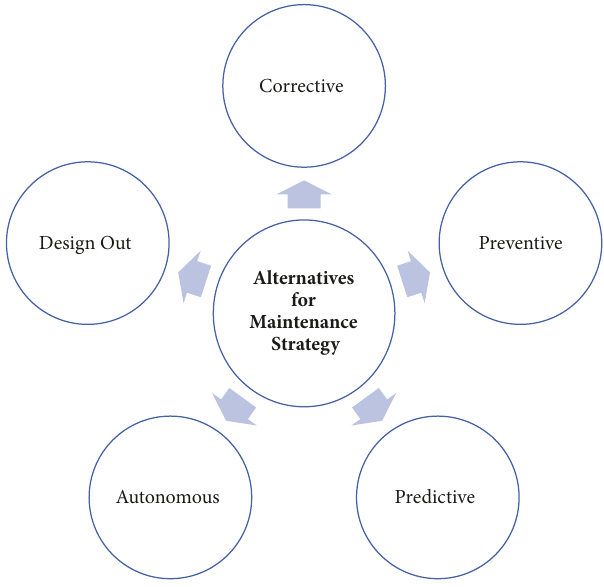
Figure 5: Alternative identified through the literature for mainte- nance strategies [14–17, 36,